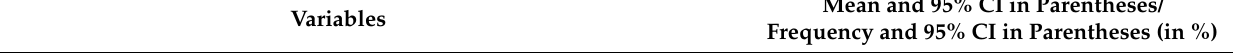
Mean and 95% CI in Parentheses/ Frequency and 95% CI in Parentheses (in